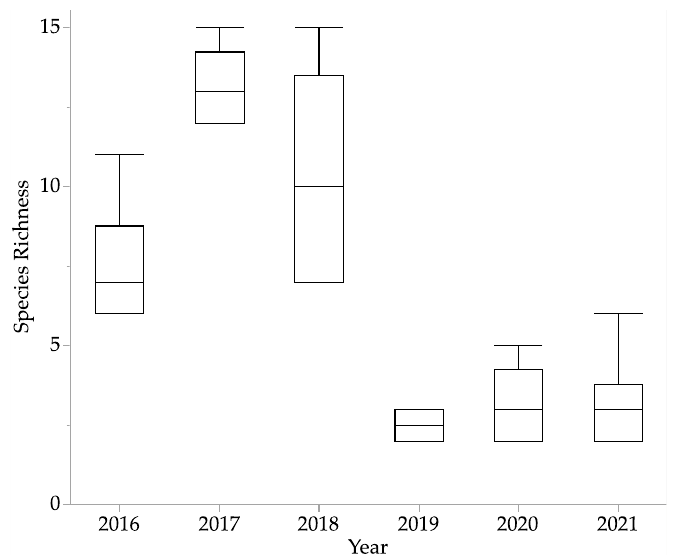
Figure 3. Vegetation plot species richness in the shallow cells of the Kearl Treatment Wetland, 2016 – 2021. Boxes represent 1st, 2nd, and 3rd quartiles. Whiskers represent minimum and maximum.